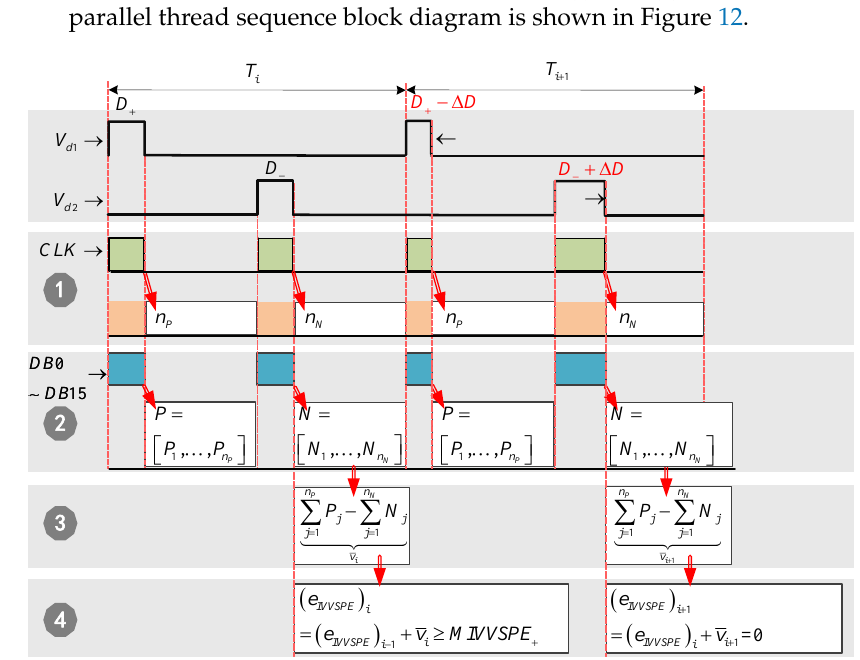
Figure 12. The block diagram of the parallel operation for positive DC bias suppression